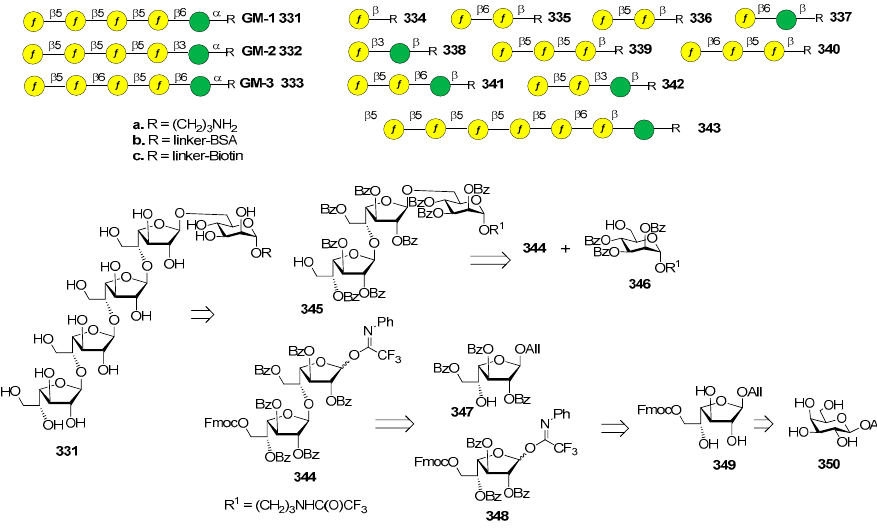
Figure 38. Synthetic fragment of A. fumigatus galactomannans reported in [254,255].